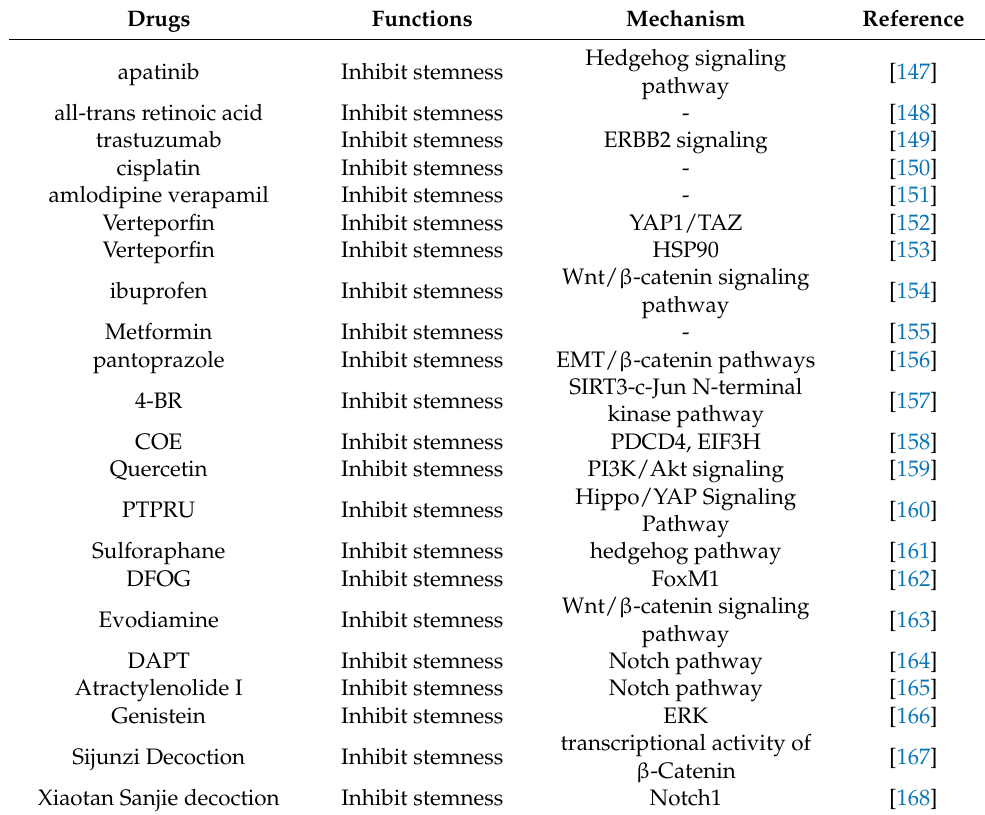
Table 6. Drugs for GC treatment by inhibiting its